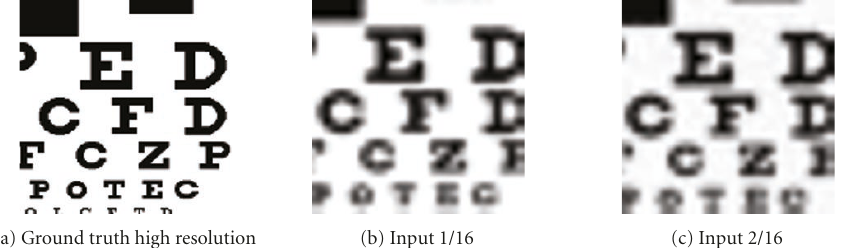
Figure 3: Synthetic data: (a) ground truth image. (b), (c) Two example low-resolution images of 30 × 30pixels, with clearly di ff erent geometric and photometric